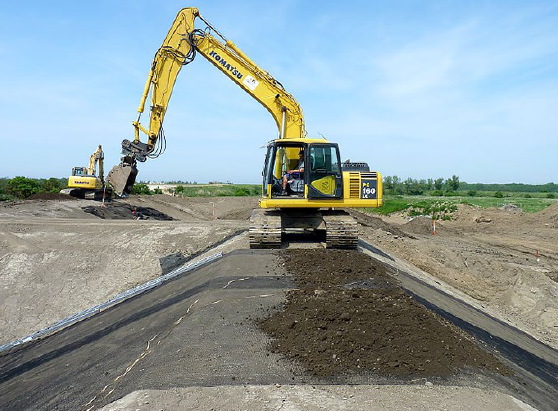
Fig. 14. Installation of the erosion control